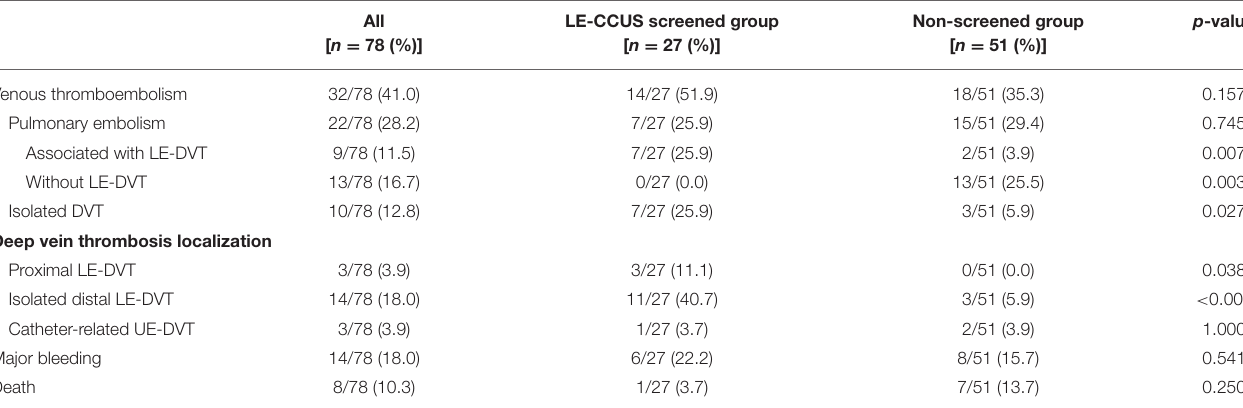
TABLE 3 | Clinical outcomes of patients according to systematic screening or not for